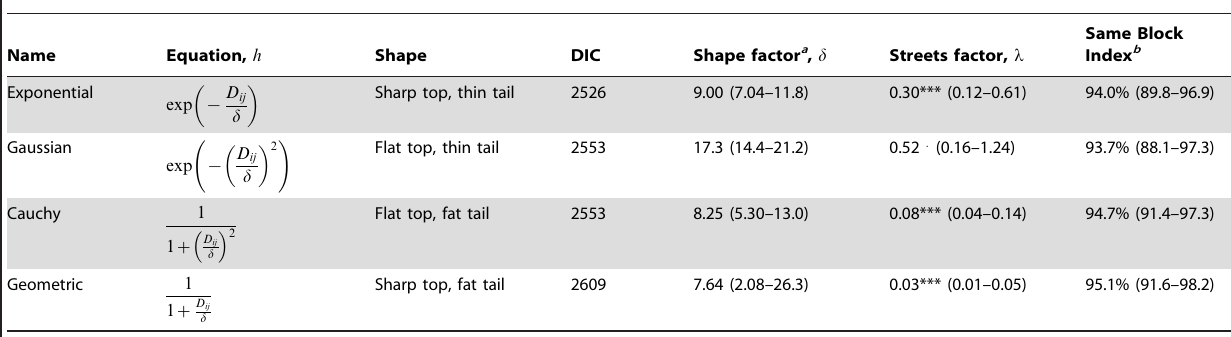
Table 1. Spatial kernels and corresponding fitted parameters.